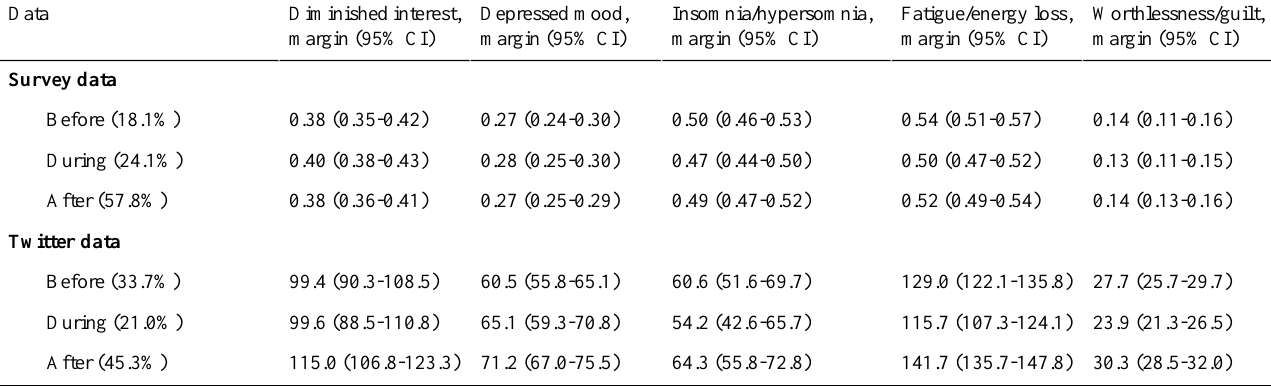
Table 1. Predictive margins of simple slopes resulting from regression analyses (model 3, survey data; model 6, Twitter data) for before, during, and after the contact ban.